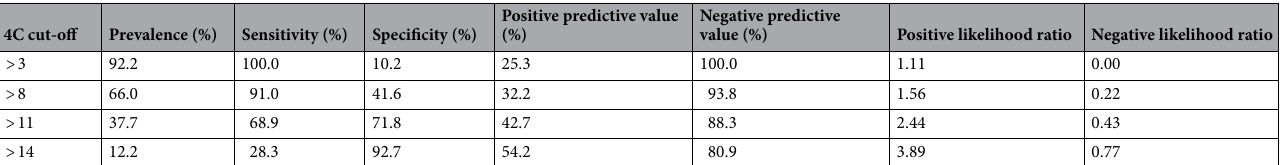
Prevalence (%) Sensitivity (%) Specificity (%)